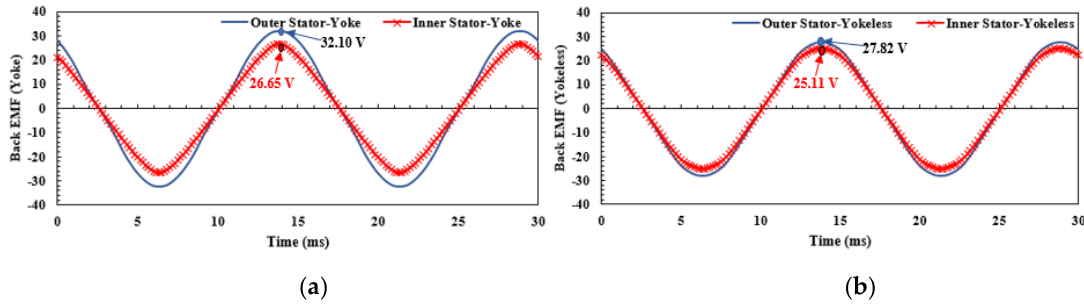
Figure 9. Back EMF comparison in DARF-PMVM: ( a ) with iron yoke rotor, ( b ) without iron yoke (yokeless) rotor.